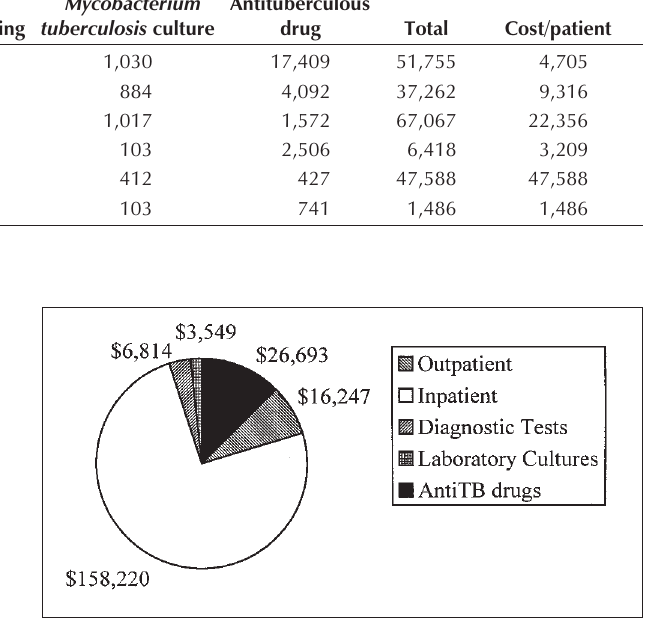
Figure 1) Total costs of paediatric tuberculosis cases by contributor to costs. TB